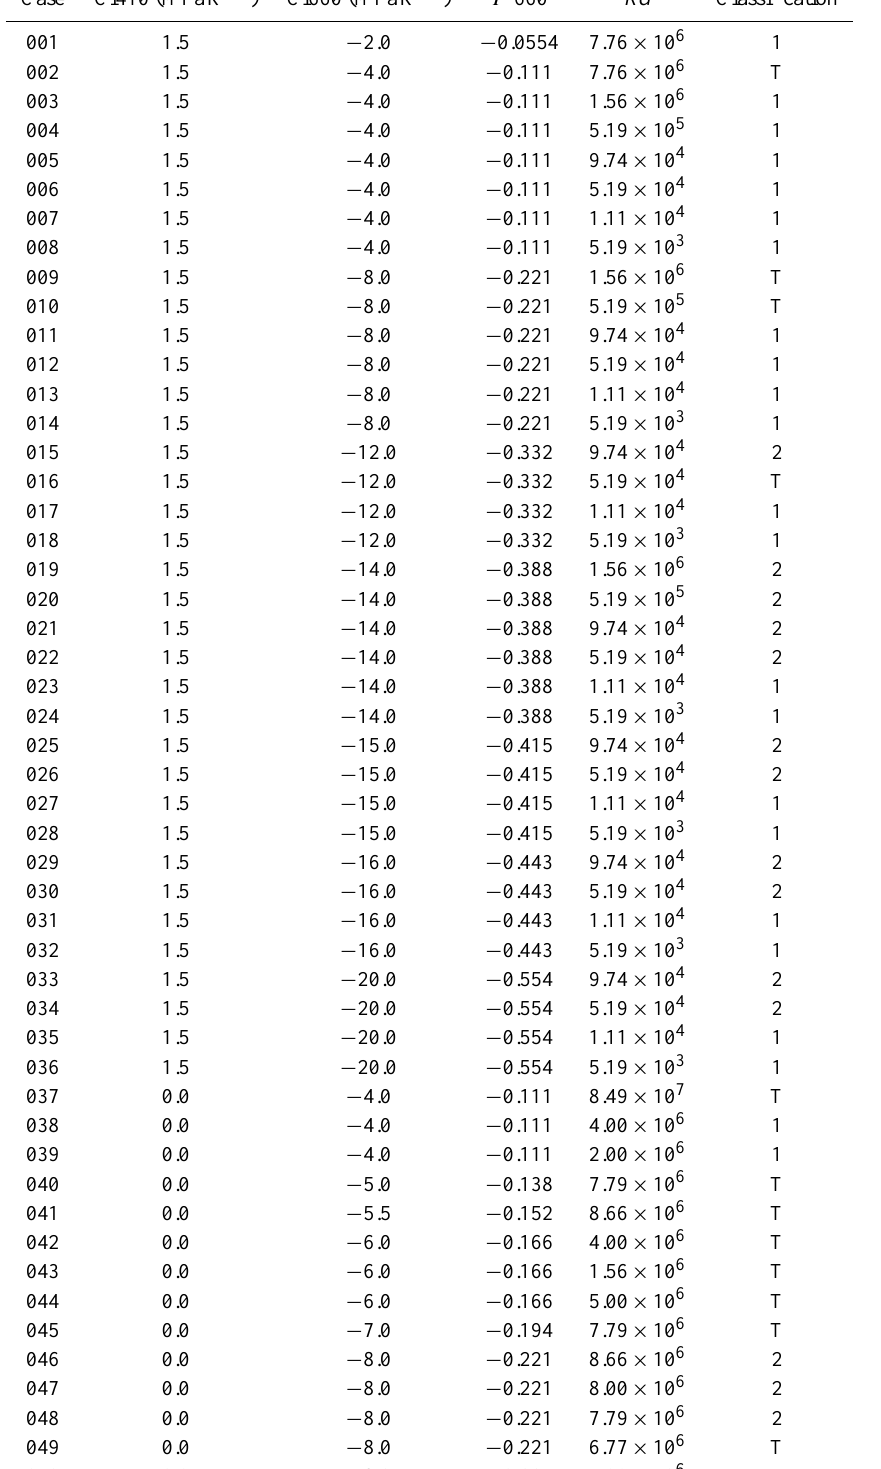
Table 2. Cases modelled with case-specific parameters and outcome. Cl410: Clapeyron slope at 410km; Cl660: Clapeyron slope at 660km; P 660: buoyancy parameter for the 660 phase change; Ra : basally heated Rayleigh number; layering status classification: 1 = whole mantle convection, 2 = two layer convection, T = transitional